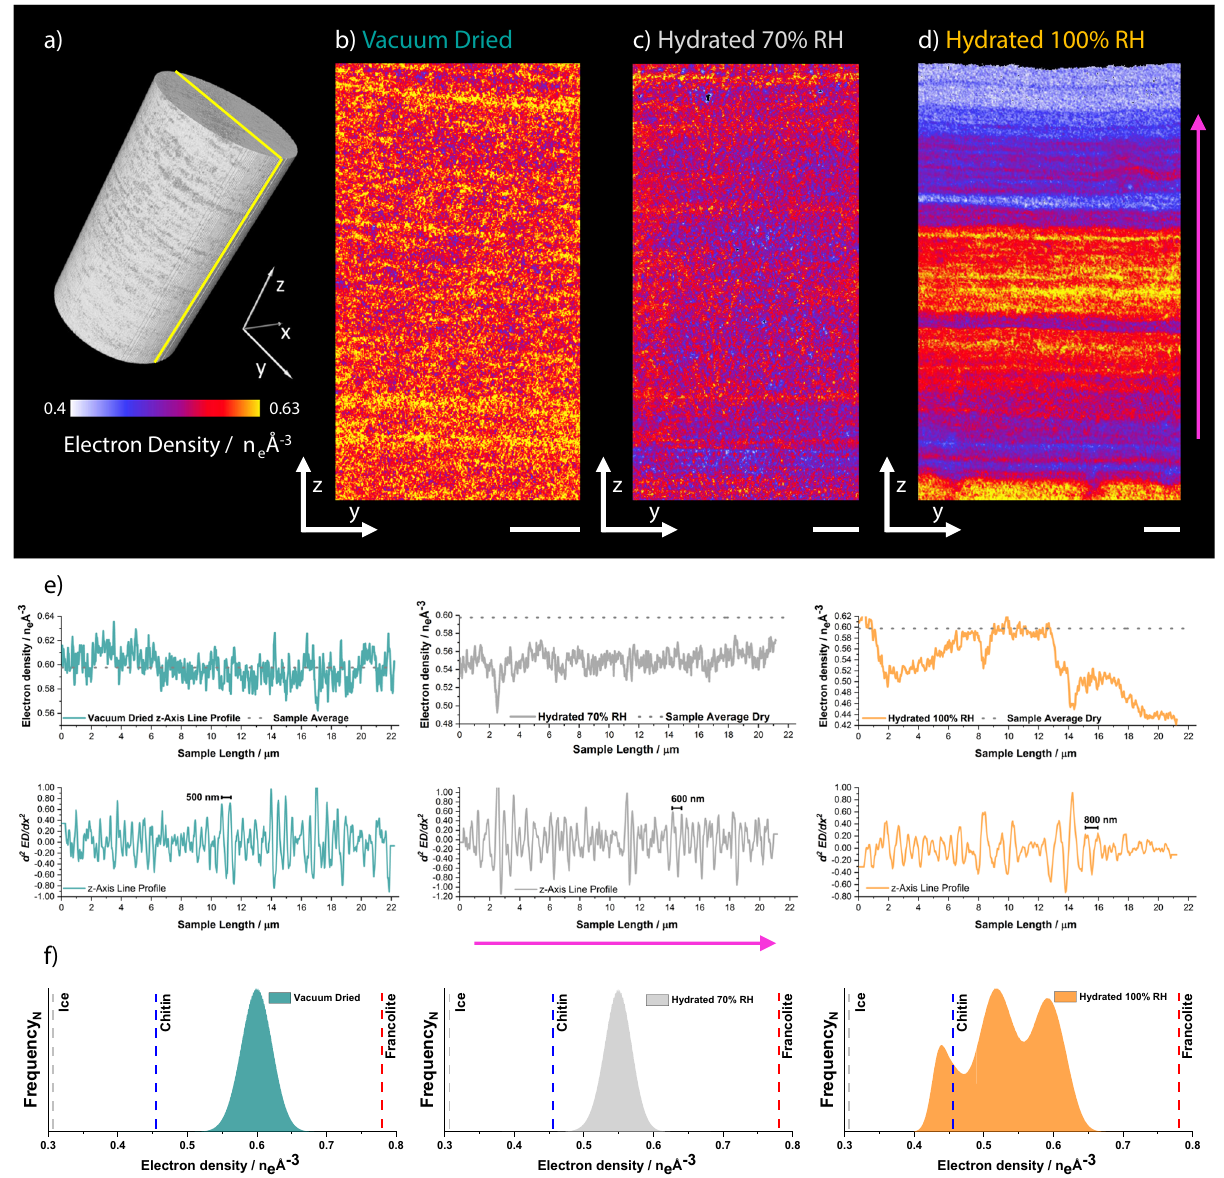
Fig. 3 Electron density tomograms of D. tenuis brachiopod shell samples at increasing hydration level. a Example volume rendering of the imaged, cylindrical, sample pillars. Sagittal cut slices through the center of b a vacuum dried sample, c a sample incubated at 70% RH, and d a sample incubated at 100% RH. The cutting plane is represented by the yellow line shown in ( a ). Scale bars are 2 µ m. Common to all cuts is a single color scale ranging from white to yellow representative of electron density values. Shown in e are sample plane averaged electron density line pro fi les normal to the laminae structure (pink arrow) alongside secondary derivatives highlighting major fl uctuations in electron density. Sample corresponding frequency normalized ( N ) electron density histograms are shown in ( f ). Further provided in f are the theoretical electron density values of the shell main components: francolite 0.78 n e Å − 3 , high molecular weight polysaccharides approximated using chitin ~0.46 n e Å − 3 , and low-density amorphous ice, 0.31 n e Å − 3 . PCXT measurements were conducted under cryogenic conditions. The voxel size of all tomograms is (38.8 nm) 3 . Source data for this fi gure are available at the University of Edinburgh DataShare, data identi fi er https://doi.org/10.7488/ds/3056 67